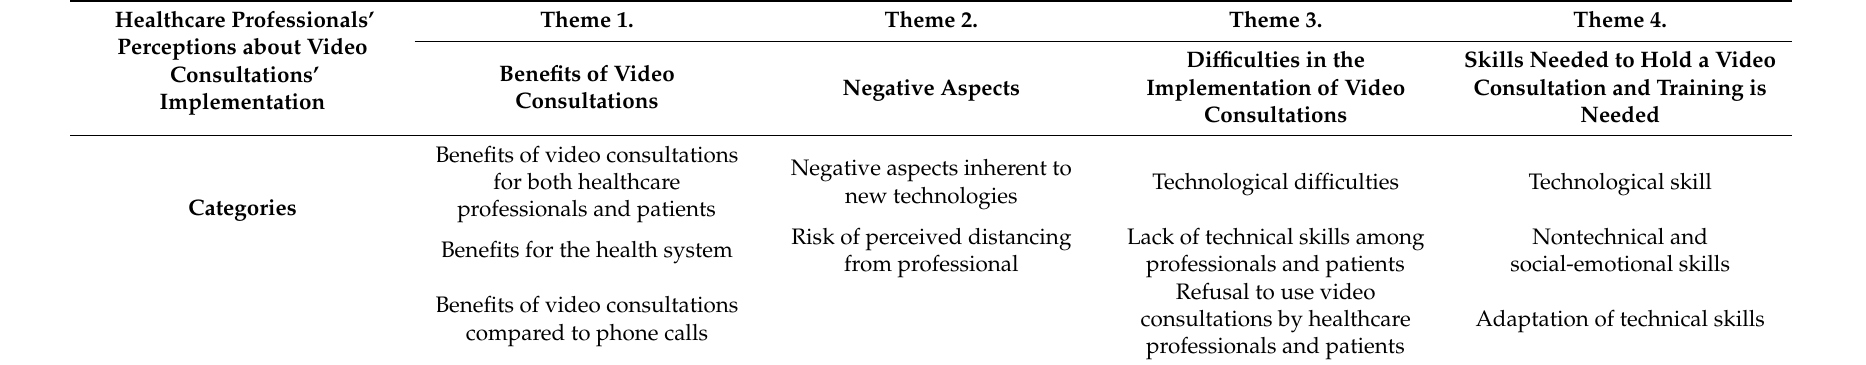
Table 2. Comprehensive list of themes and categories identified after thematic